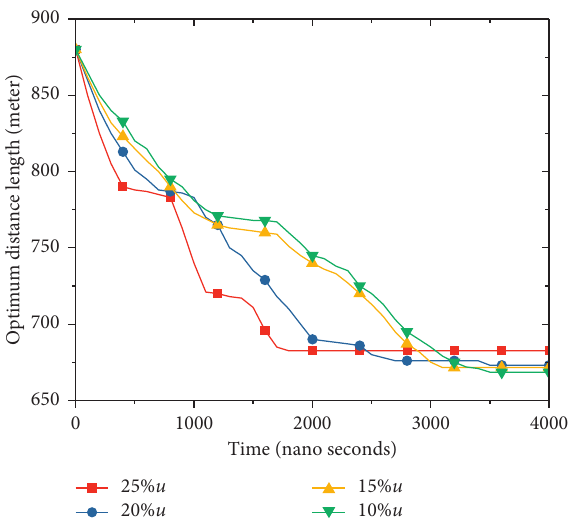
Figure 9: The load status versus time and r